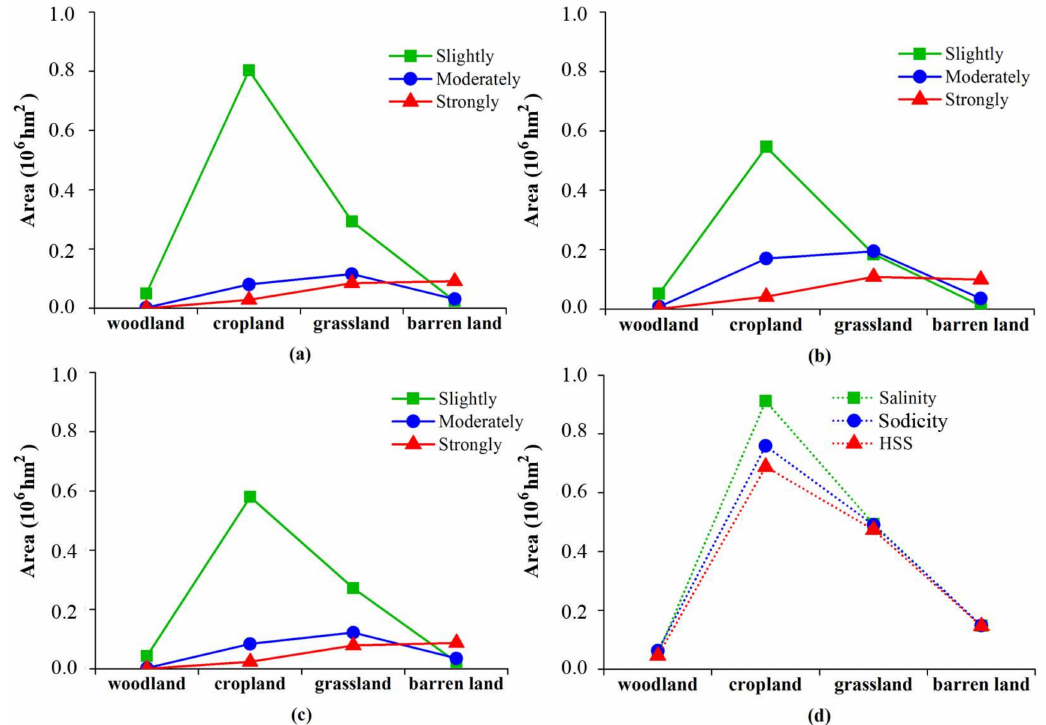
Figure 6. The areas of soil salinity, sodicity, and HSS at different levels with regard to land cover ( a ) Salinity ( b ) Sodicity ( c ) HSS ( d ) Affected